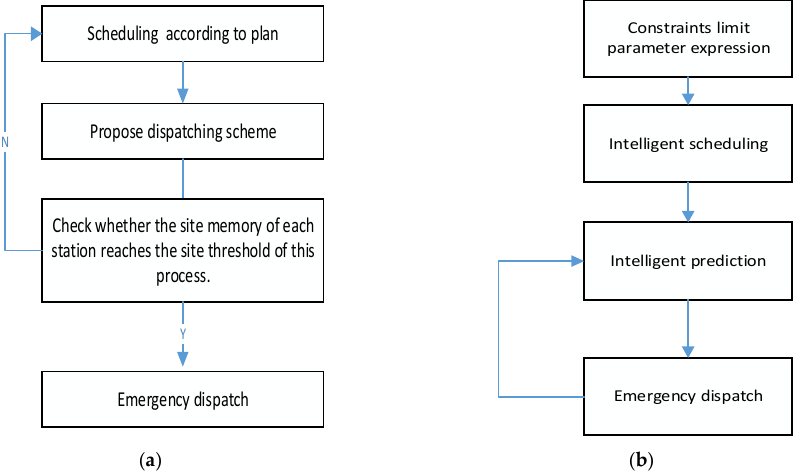
Figure 4. Scheduling flow diagram: ( a ) general scheduling and ( b ) multi-constraint intelligent scheduling.